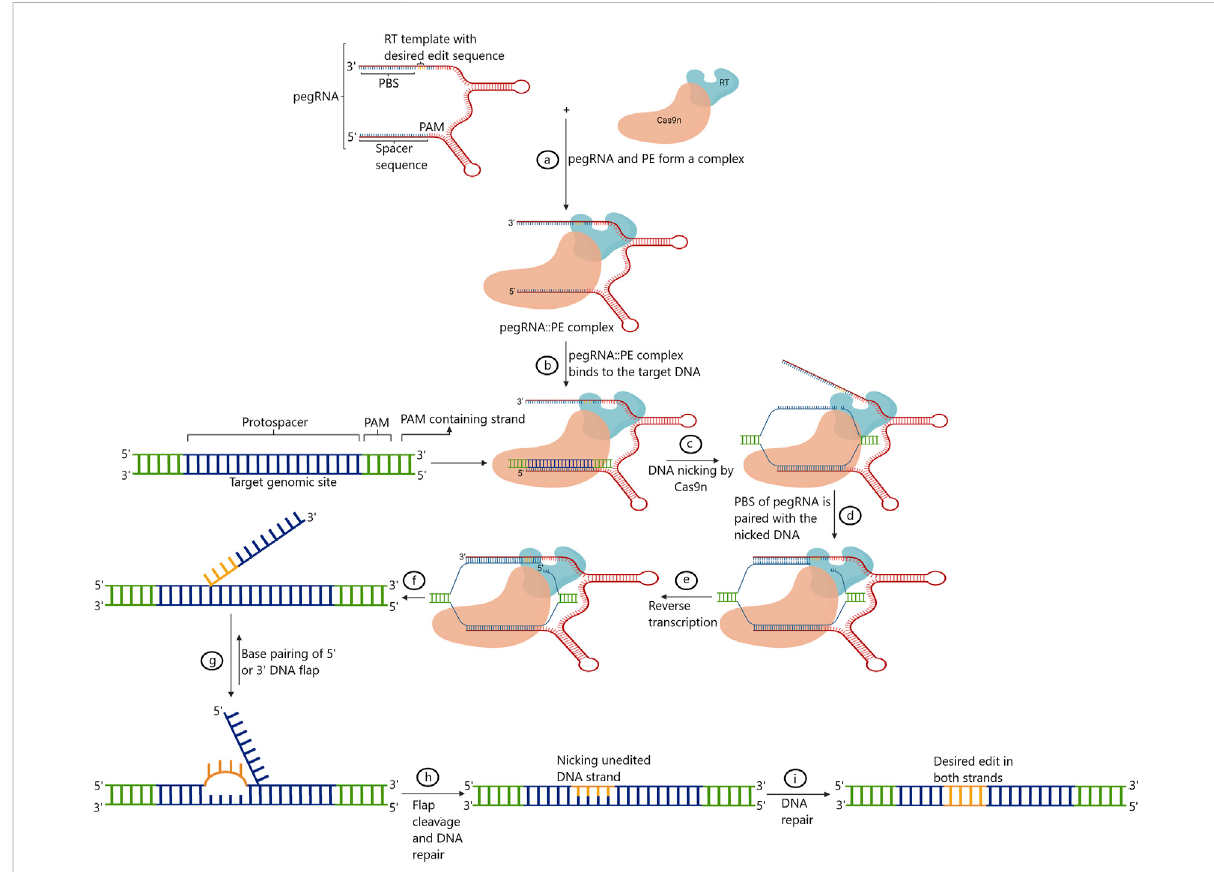
FIGURE 4 Diagrammatic representation of the Prime editing. sgRNA: single-guide RNA; Cas9n: Cas9 nickase; PAM: protospacer adjacent motif; PBS: primer binding site; RT: reverse transcriptase; pegRNA: prime editing guide RNA; PE: prime editor (adapted from Hassan et al.